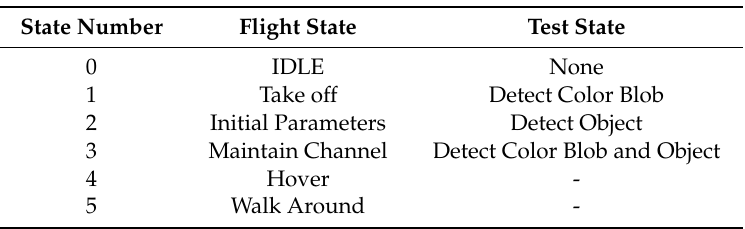
Table 2. States in the